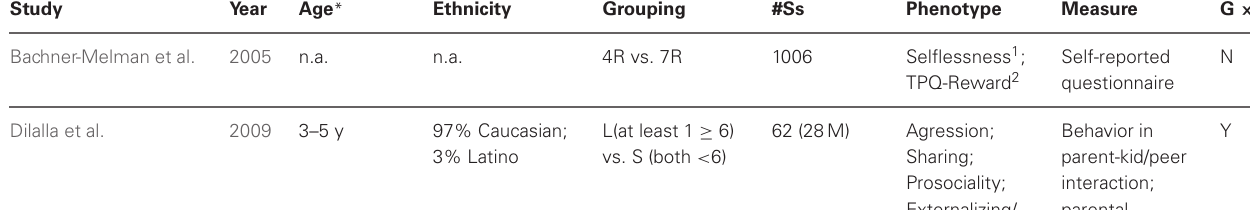
Table 1 | Study characteristics (in chronological